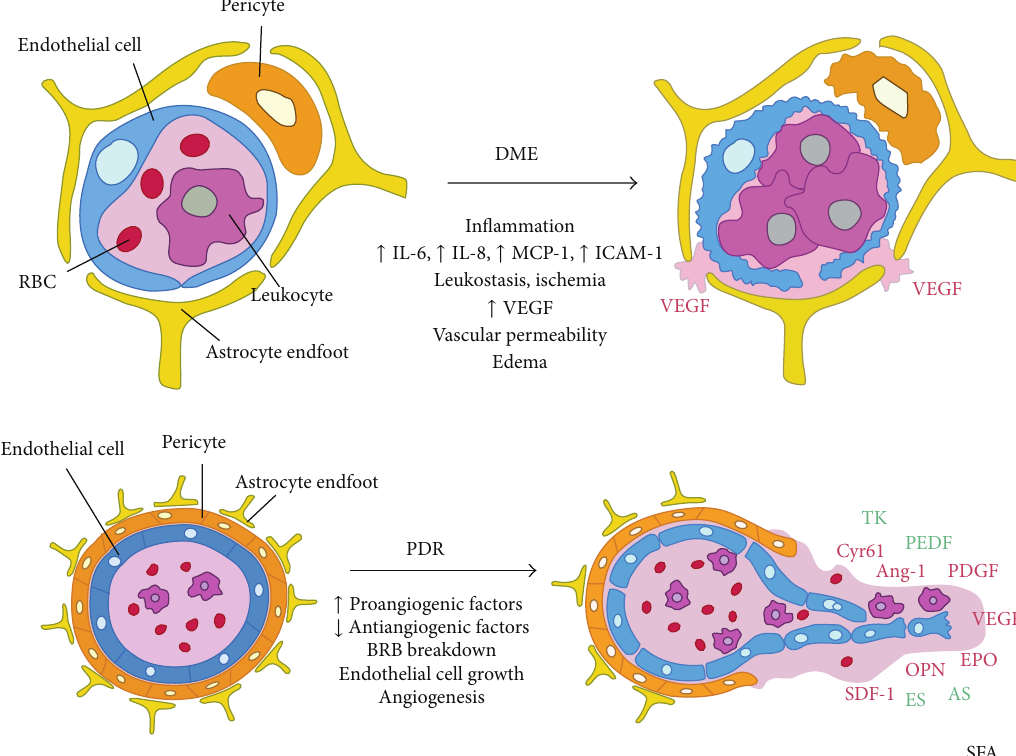
Figure 2: Inflammatory cytokines and their role in PDR. Source: